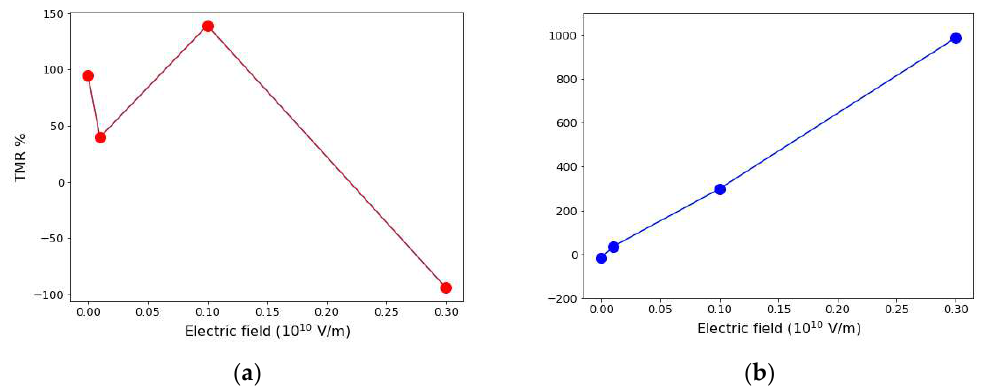
Figure 8. Dependence of the tunneling magnetoresistance on the tunnel barrier material for different magnitudes of the applied electric field for hBN ( a ) and MoS 2 ( b ).